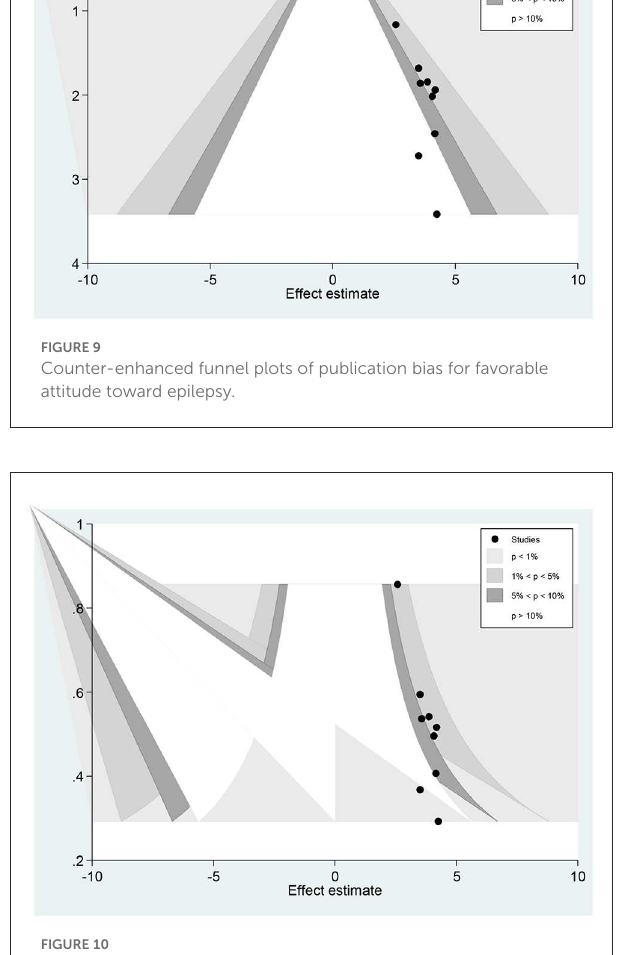
FIGURE10 Meric inverse counter enhanced funnel plots of publication bias for favorable attitude toward epilepsy.